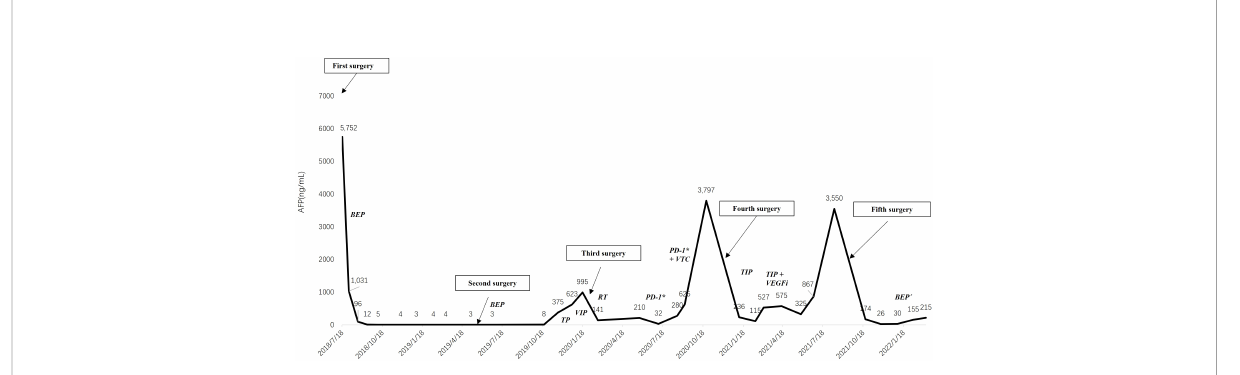
FIGURE 2 The changing trend of serum alpha-fetoprotein. BEP, bleomycin, etoposide and cisplatin; TP, docetaxel and carboplatin; VIP, ifosfamide, cisplatin and etoposide; RT, radiotherapy; PD-1*, tislelizumab; VTC, vinorelbine tartrate capsules; TIP, paclitaxel, ifosfamide and cisplatin; VEFGi, bevacizumab. *: Tislelizumab is an anti-programmed cell death protein-1 (PD-1)